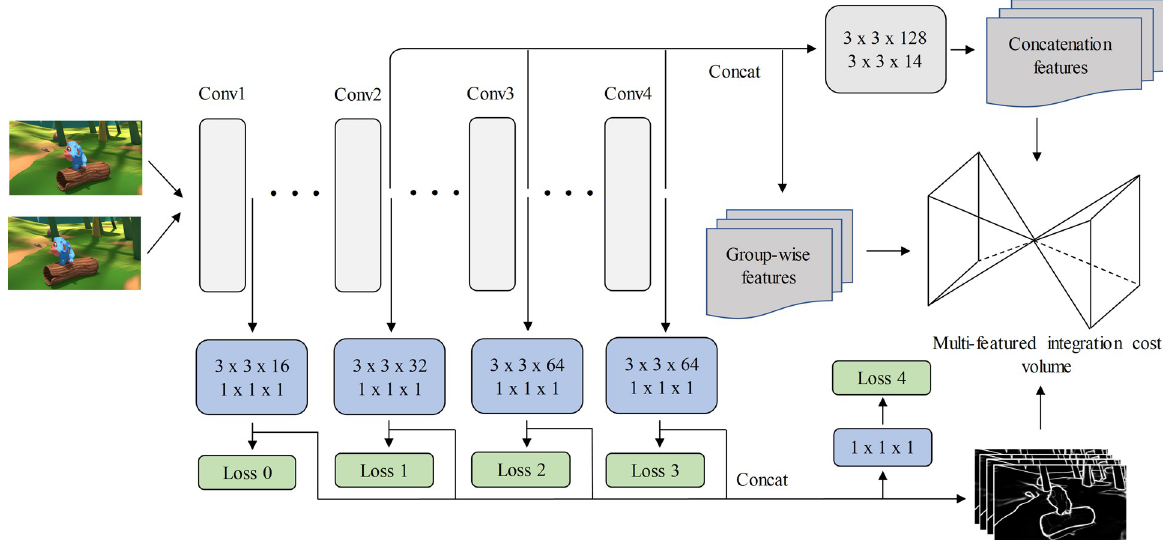
Fig 4. Pipeline of feature extraction